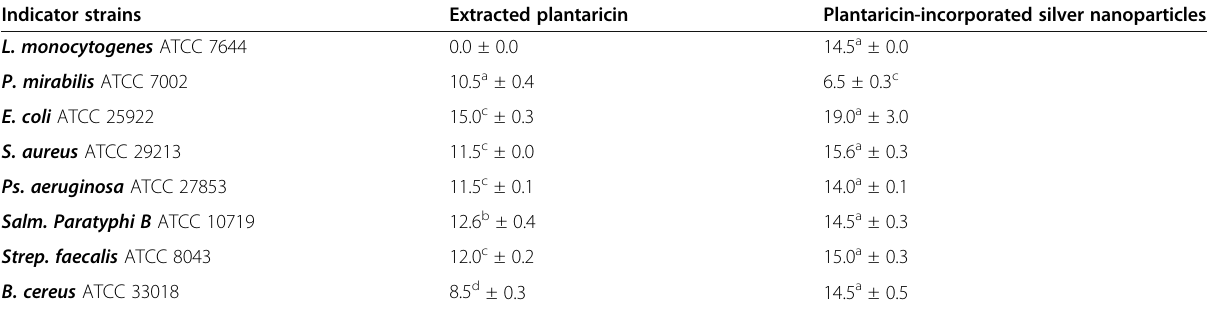
Table 3 The antibacterial activity of extracted plantaricin (EX-PL) and plantaricin-incorporated silver nanoparticles (PL-SNPs) expressed as diameter of inhibition zones (mm) Indicator strains